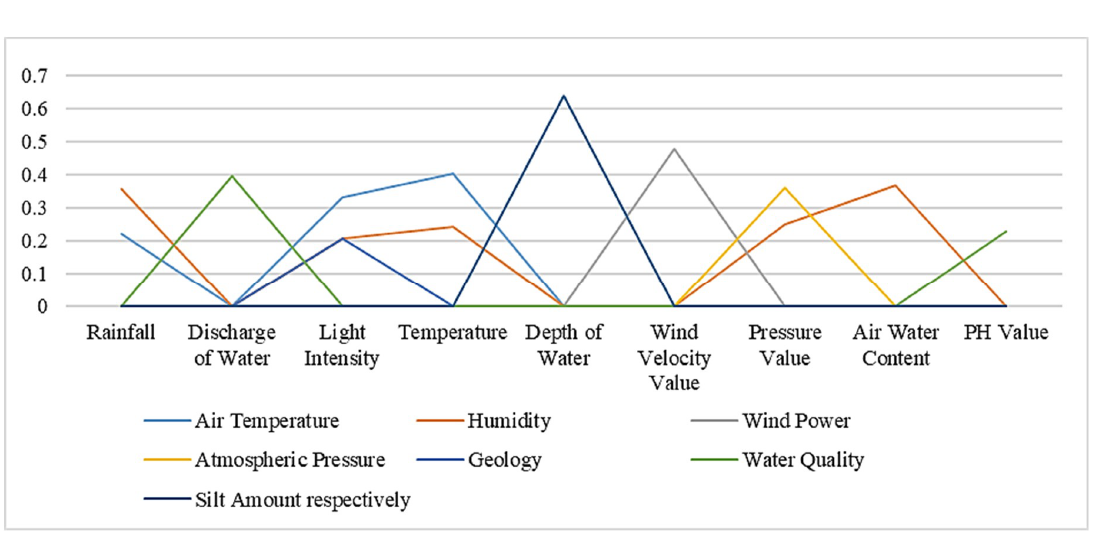
Figure 4. Similarity results based on structural strategy.